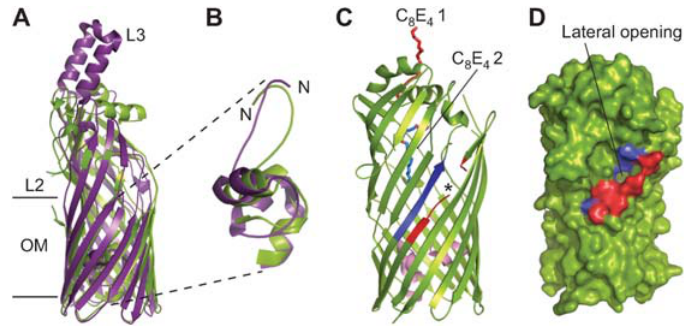
Figure 5 Structural comparison of the toluene channels TodX and TbuX with E. coli FadL. (A) Cartoon representations of P. putida F1 TodX (green) superimposed on E. coli FadL (purple). The locations of loops L2 and L3 are indicated. (B) Close-up of the hatch domains, with coloring and orientation as in (A). (C) C Figure 2). Strand S2 (residues 69–82) is colored red, strand S3 dark blue. The location of the lateral opening in TodX is indicated by an asterisk and the hatch domain is shown in pink. (D) Surface view of TodX showing the lateral opening in the wall of the